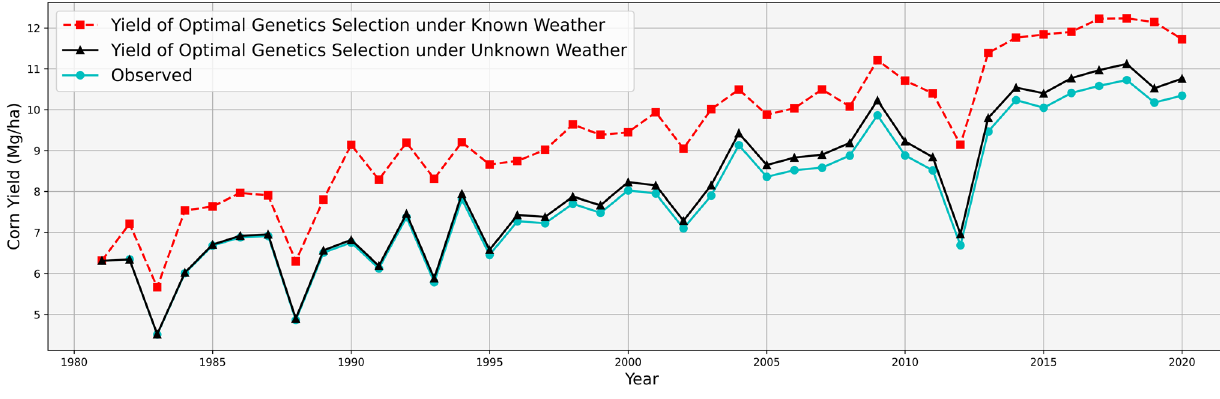
Fig. 6 Comparison of observed corn yield with improved yield from optimal seed selection under known and unknown weather scenarios. In both scenarios, optimal genotype were selected from all seeds in all counties in the Corn Belt that were historically available at the time of